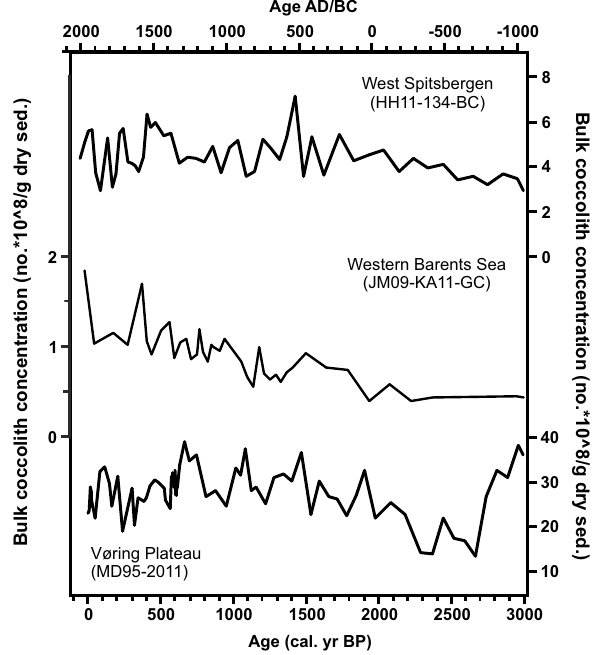
Fig. 3. Bulk coccolith concentration records (coccoliths × 10 8 g − 1 dry